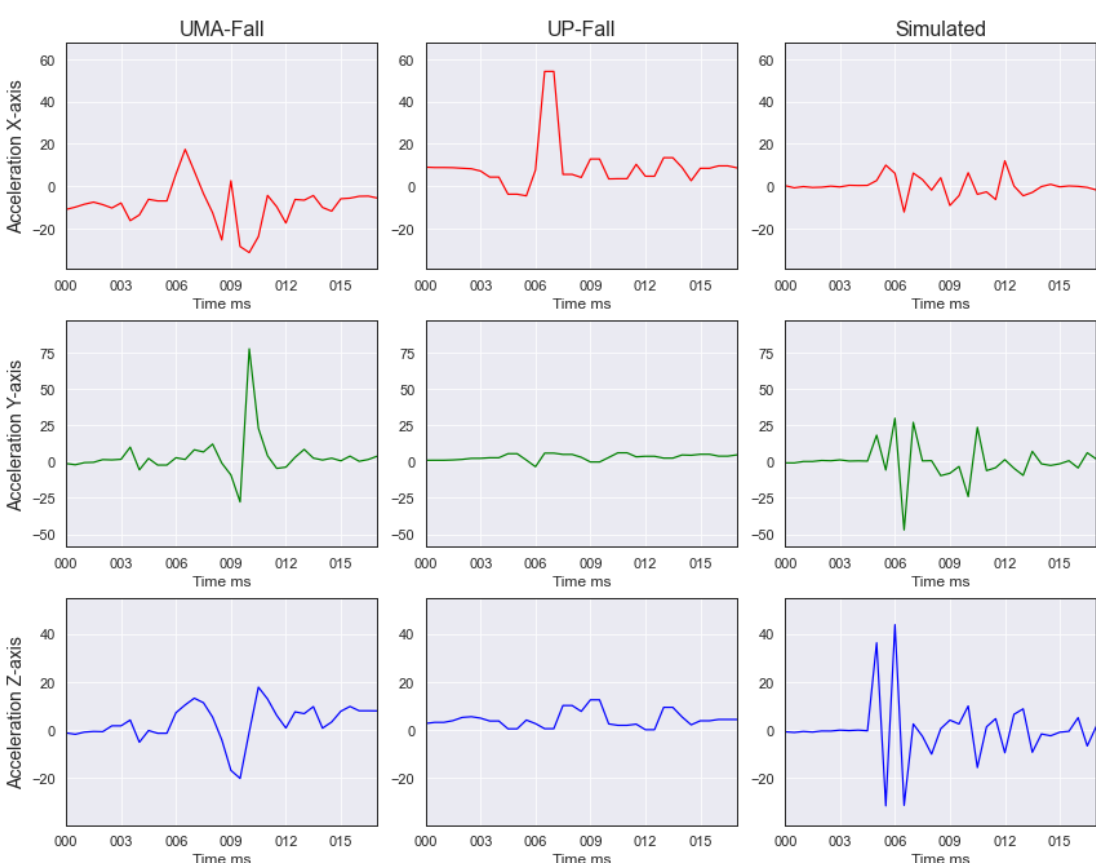
Figure 5. Unscaled accelerations for a forward fall event from the UMA-Fall dataset ( left ), UP-Fall dataset ( center ) and our simulated dataset ( right ), on the three